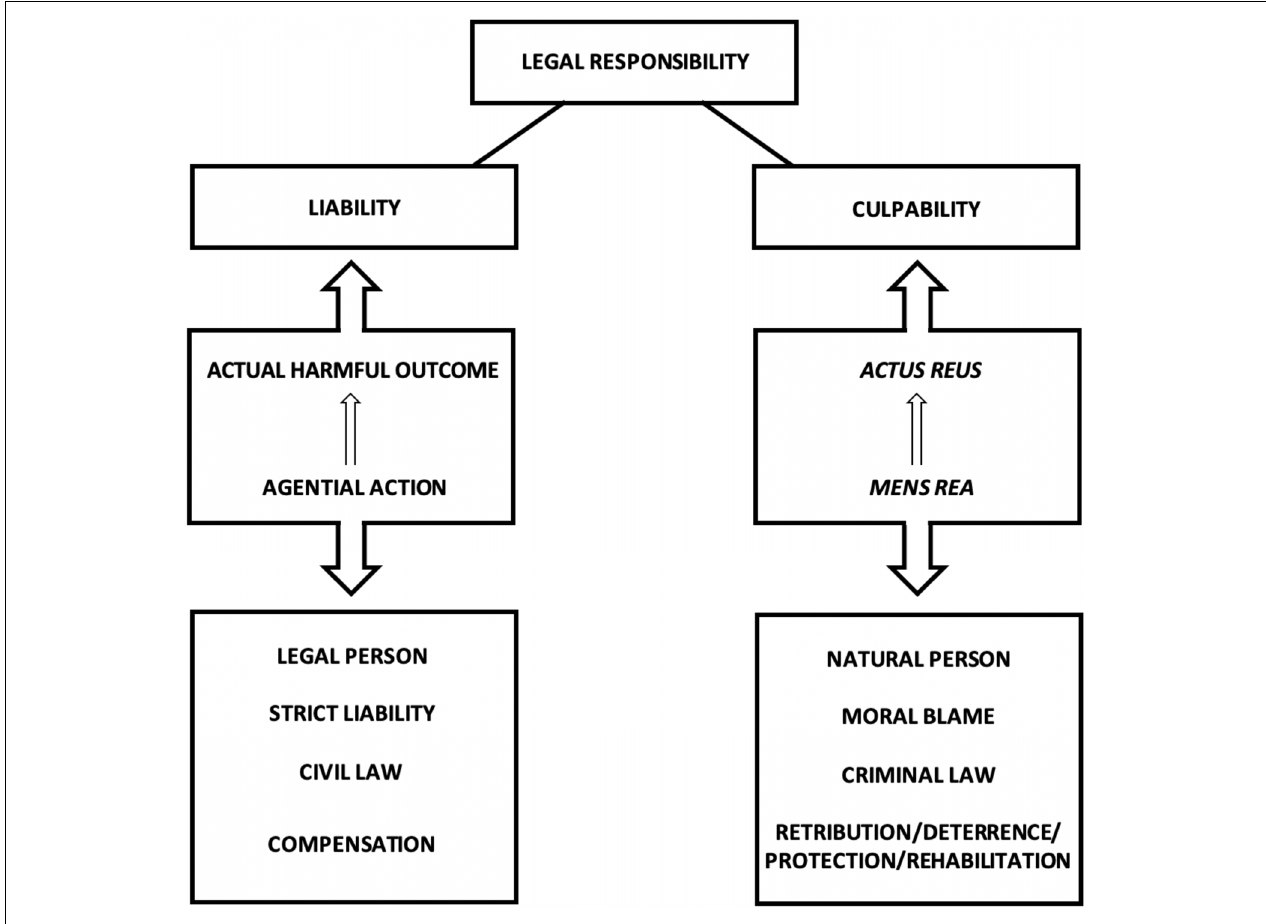
FIGURE 2 | Legal responsibility can be interpreted to have two elements, or aspects: culpability and liability ( Box 1